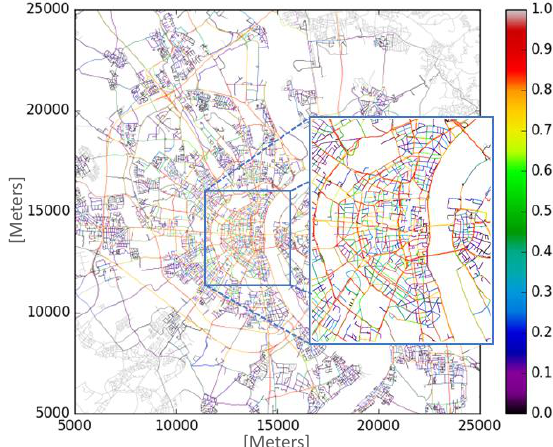
Figure 3. Road network of Cologne used in the simulation.